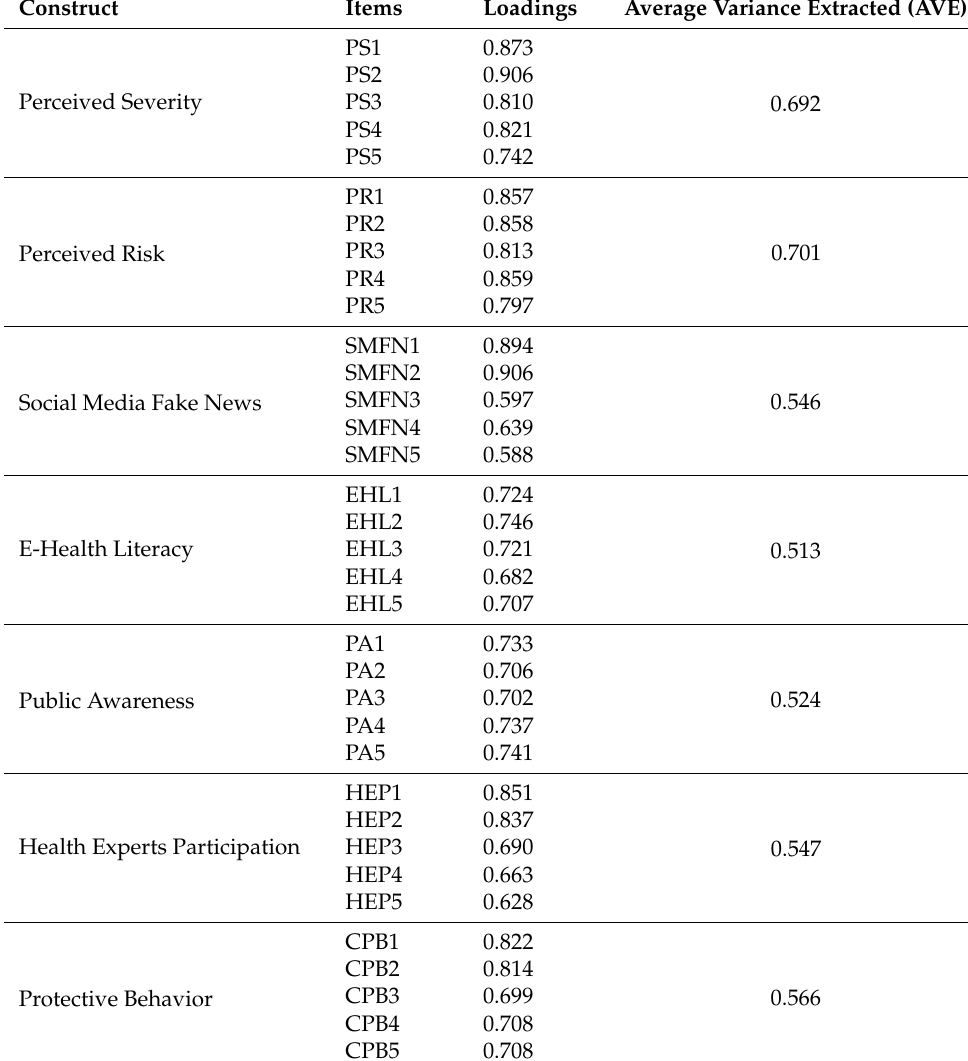
Table 4. Convergent Validity Measurement